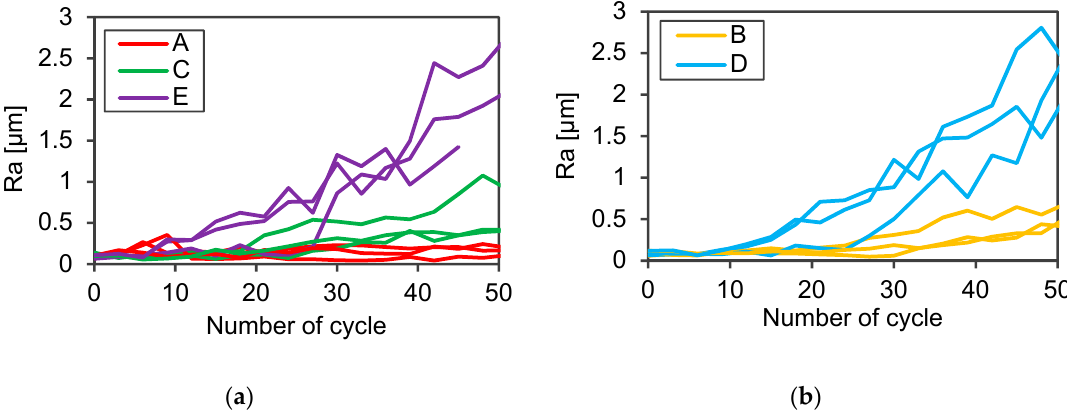
Figure 13. Repeatability of change in Ra with number of cycle obtained for 1 mm gap spacing. ( a ) samples A, C, and E; ( b ) samples B and D.